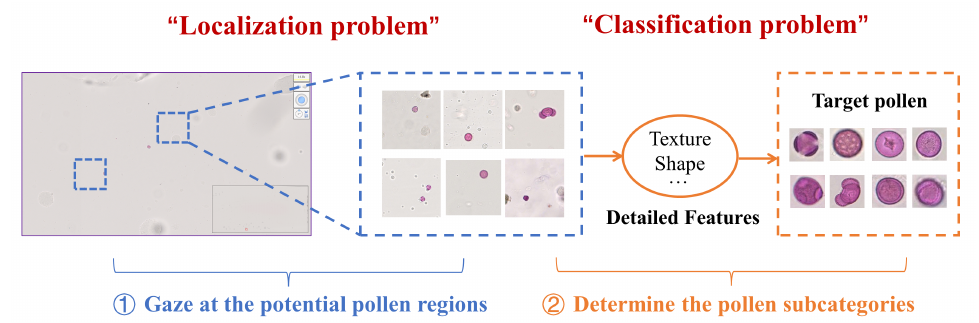
Figure 1. The pollen identification process in a progressive manner from the